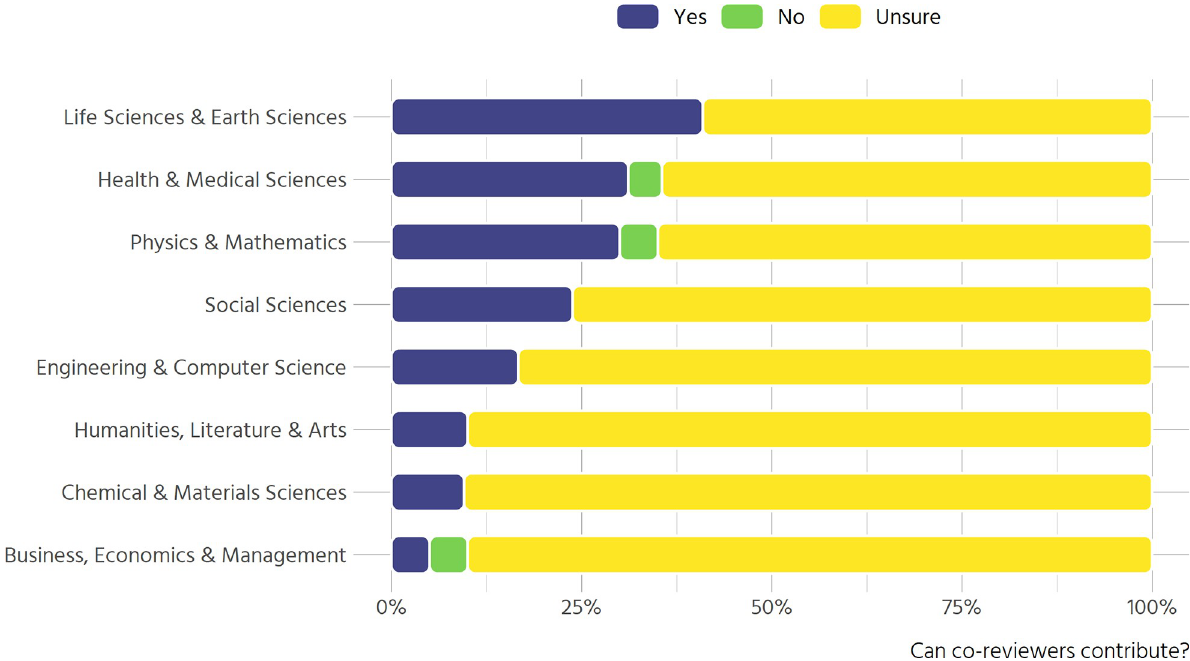
Fig 5. Clarity of co-review policies (n =